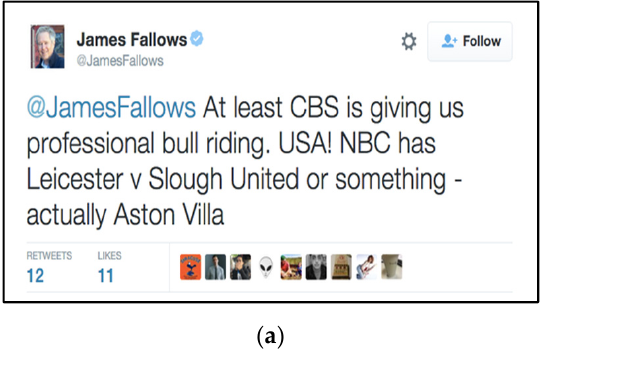
Figure 2. ( a ) Sports tweet no hashtags [12]. ( b ) Positive with hashtags [13].